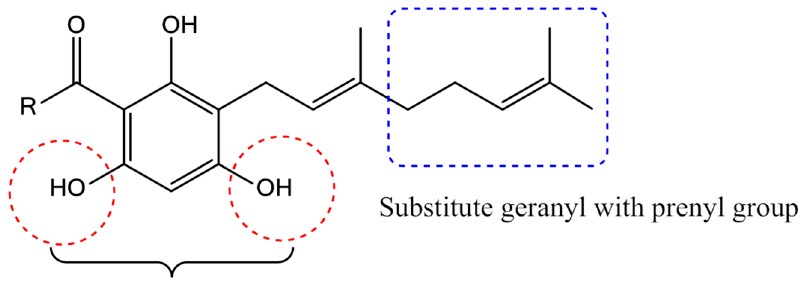
Figure 2. Modifications carried out on the geranyl and hydroxyl groups of tHGA analogues.